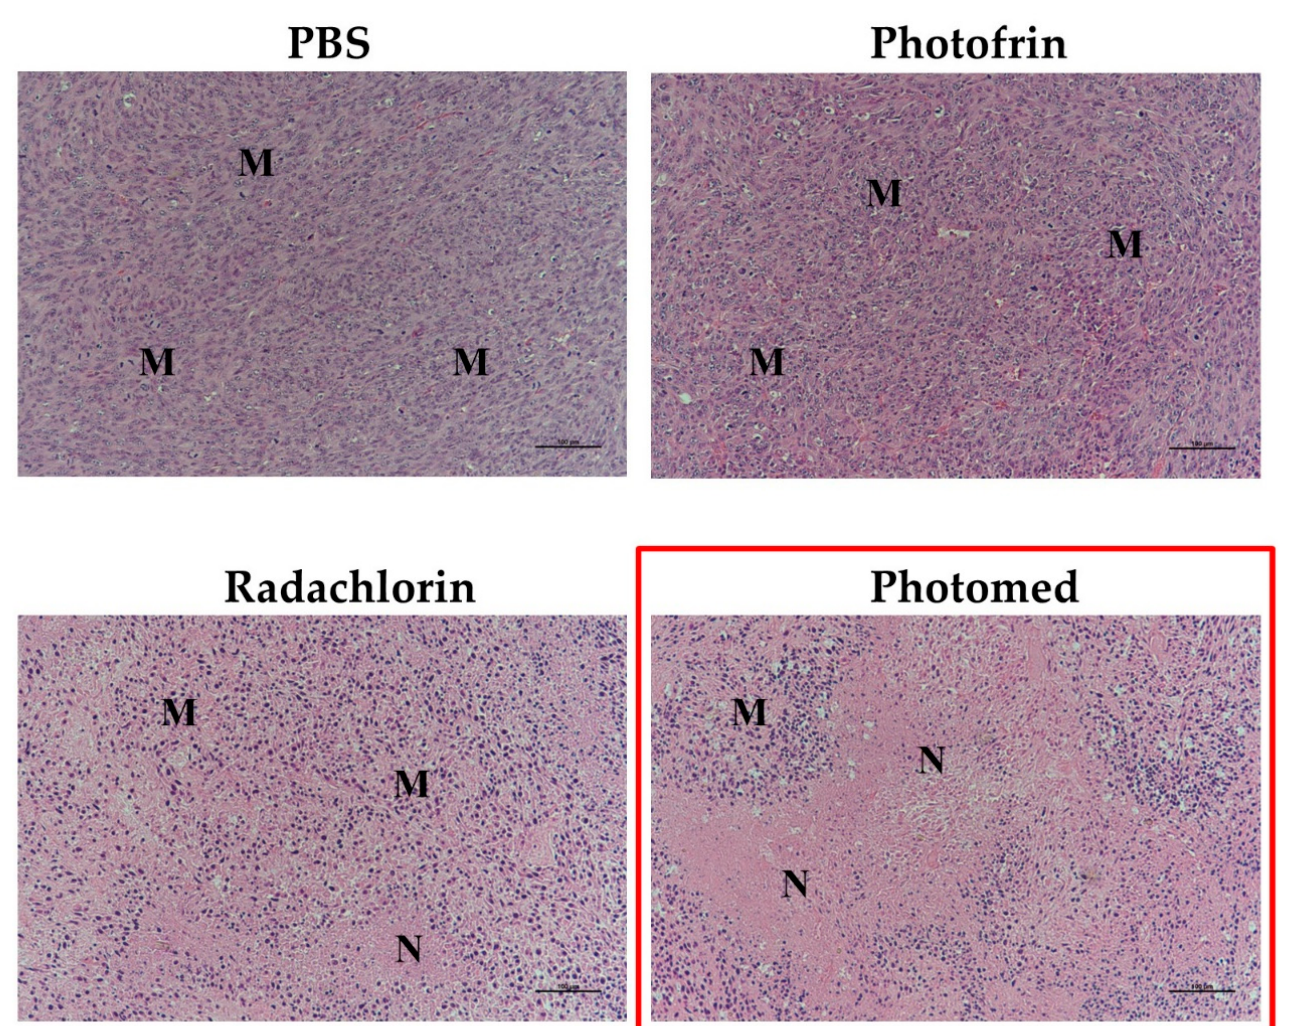
Figure 9. The representative histological analysis of tumor tissues from SCC VII tumor-bearing mice on day 10, after double (on days 0 and 7) intravenous injection of PBS, Photofrin, Radachlorin and Photomed with light irradiation (on days 0 and 7) 3 h after each administration (M: mitotic area, N: necrotic area). The scale bar in images represents 100 μ m.